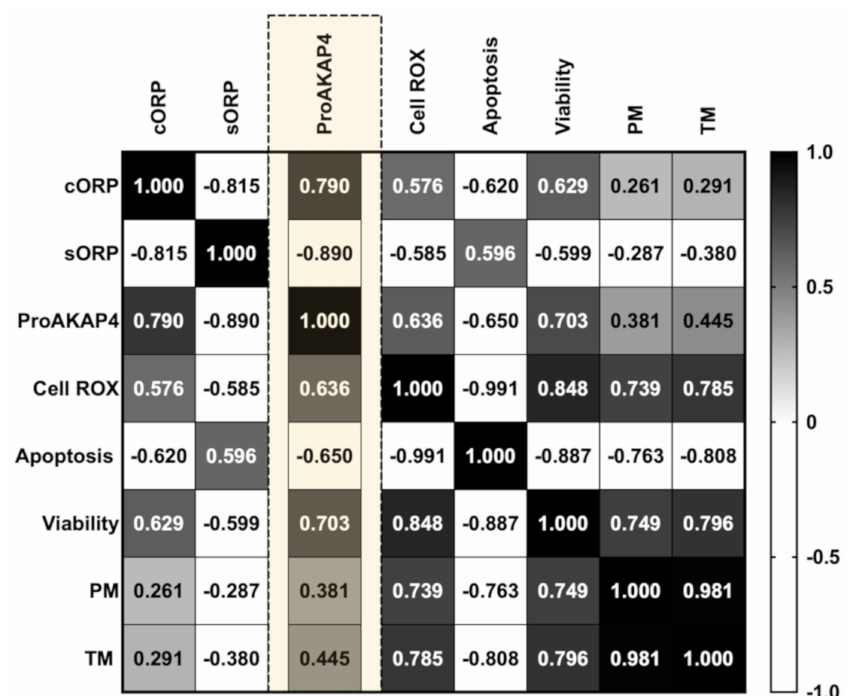
Figure A2. Correlation matrix of all sperm quality markers studied. The three experimental groups (fresh, cooled, and cryopreserved) are included to calculate correlation matrix. The R squared value between two parameters is represented in each cell. Black indicates positive correlations and white indicates negative relationships (not included in the individual correlation studies presented in the manuscript). The color intensity represents the strength of the correlation between two sperm quality parameters. To perform the correlation matrix of sperm quality parameters, the same number of samples is required in each analysis; for this reason, a total of five males were analyzed in each experimental